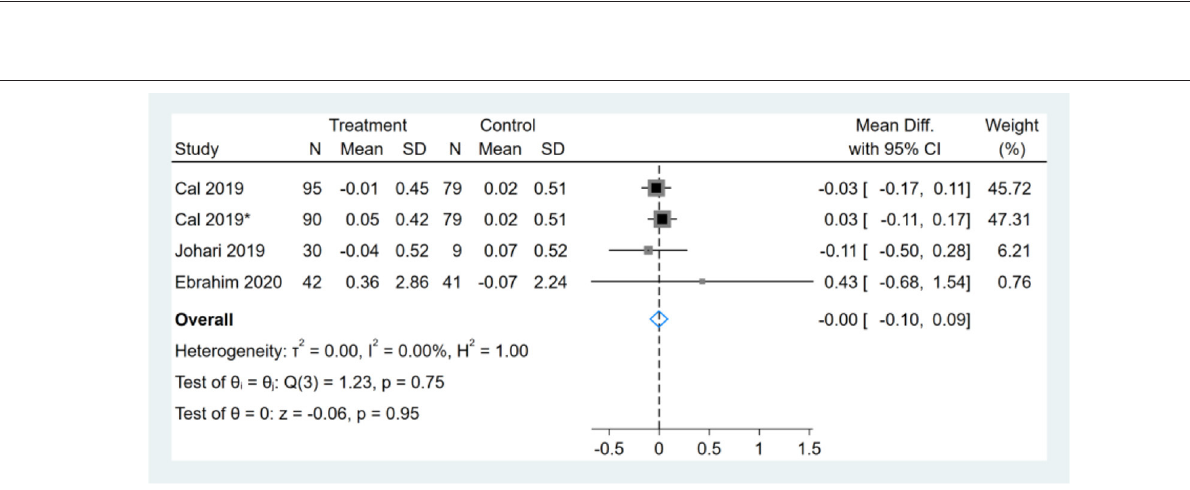
Frontiers in Nutrition | www.frontiersin.org